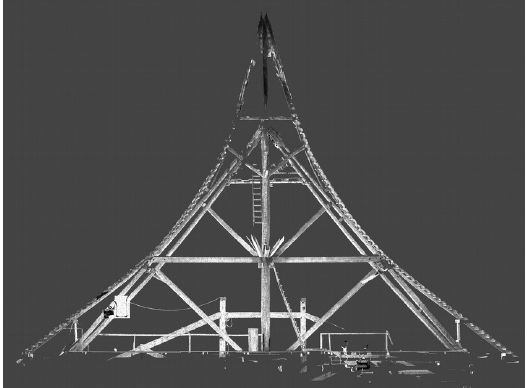
Figure 5. Longitudinal section of the pagoda. The main structural elements are extrapolated thanks to the box tool.